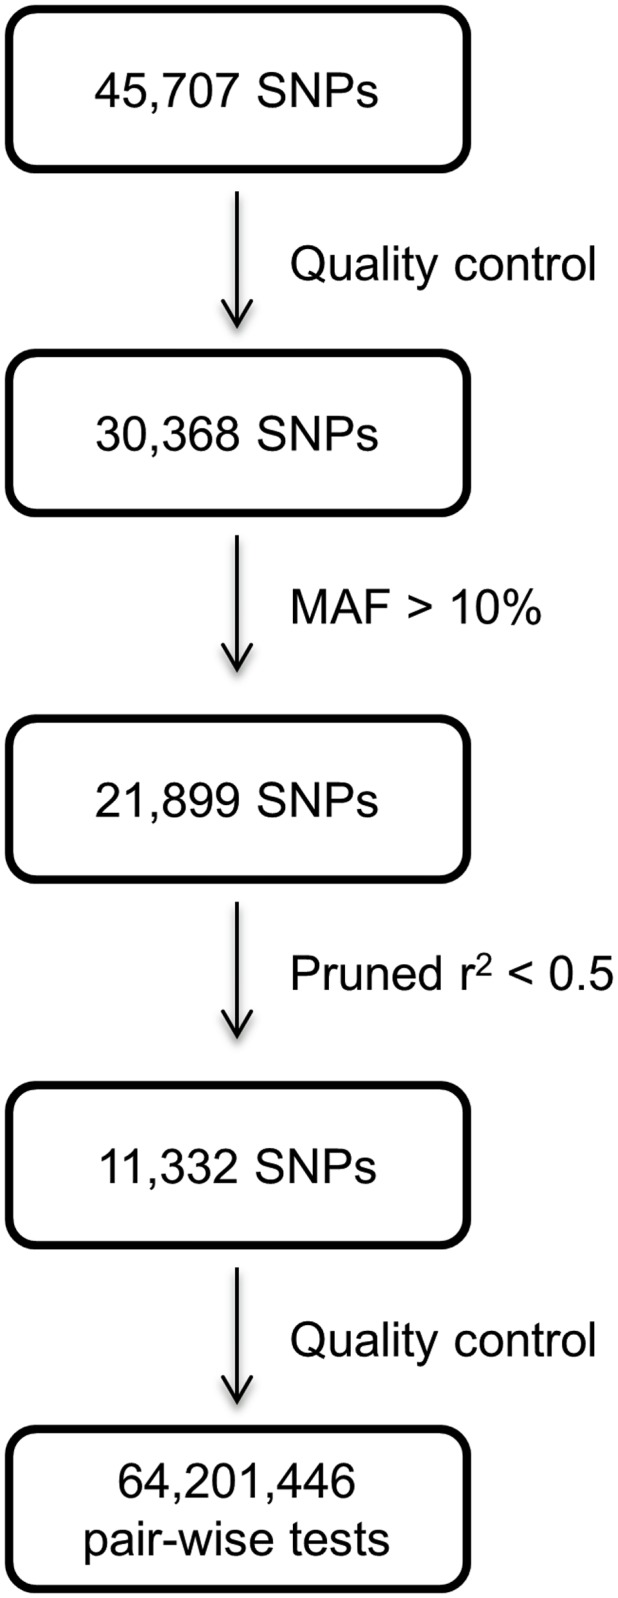
SNP selection process for the secondary analysis.